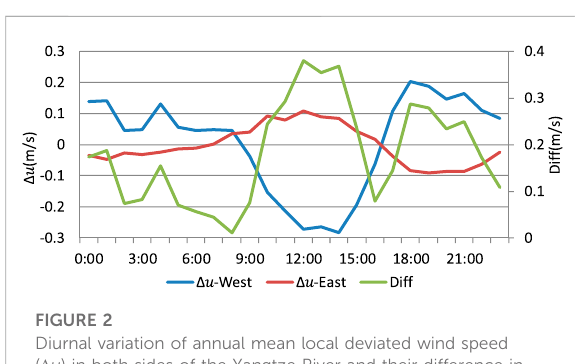
FIGURE 2 Diurnal variation of annual mean local deviated wind speed ( Δ u ) in both sides of the Yangtze River and their difference in 2011